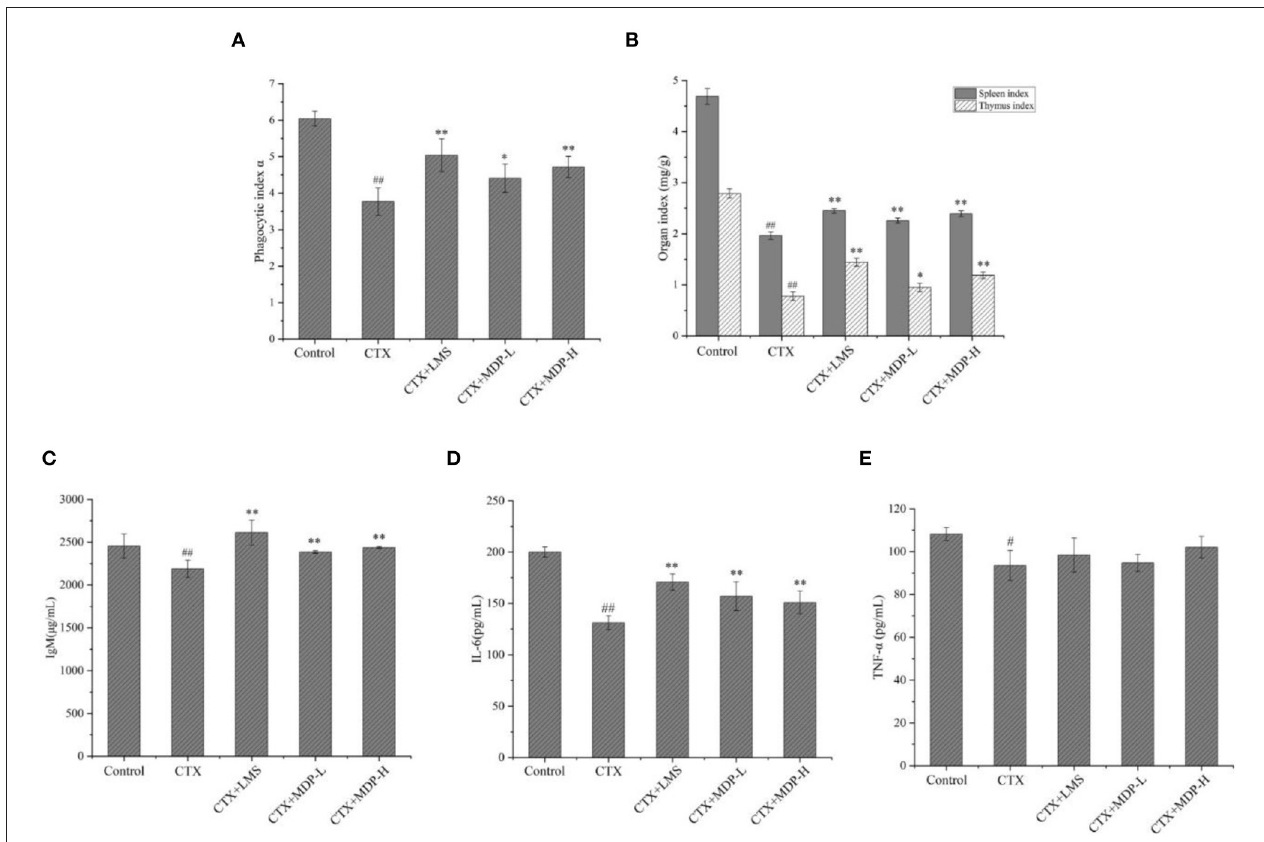
FIGURE 8 | The immunological activities of MDP in vivo. (A) Effect of MDP on the phagocytic index α . (B) Effect of MDP on the spleen and thymus indices in mice induced by CTX. (C) Effect of MDP on the secretion of IgM in serum of mice induced by CTX. (D) Effect of MDP on the secretion of IL-6 in serum of mice induced by CTX. (E) Effect of MDP on the secretion of TNF- α in serum of mice induced by CTX. Values are given as means 0.05, ## P < 0.01 vs. control group; * P < 0.05, ** P < 0.01 vs. CTX